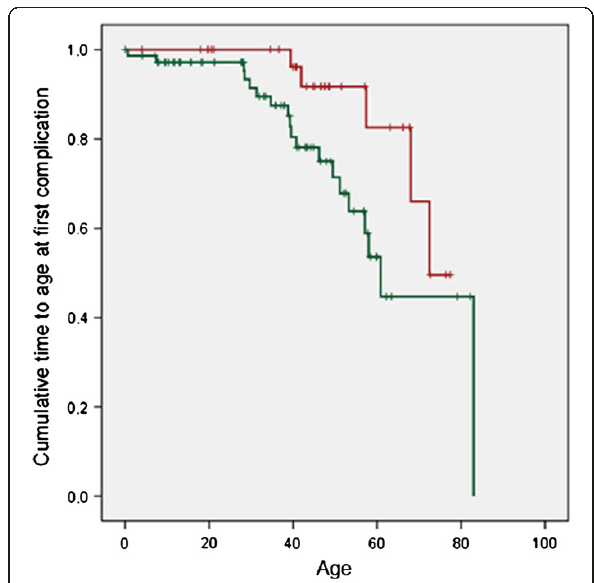
Figure 4 Age at first complication or therapeutic